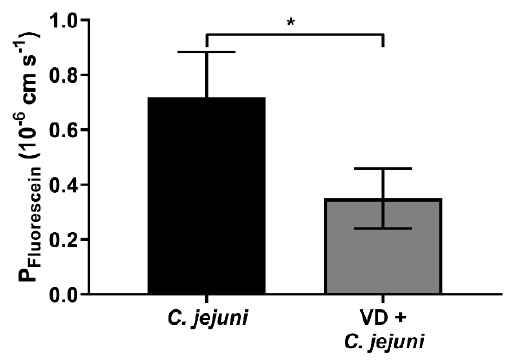
Figure 3. Vitamin D treatment prevents C. jejuni -induced barrier dysfunction in vivo. Secondary abiotic IL-10 − / − mice were orally infected with 10 8 colony forming units (CFU) C. jejuni. Cholecalciferol was administered via the drinking water ad libitum four days prior the infection with C. jejuni . Six days after infection with C. jejuni , mice were scarified, colonic biopsies were mounted immediately in miniaturized Ussing chambers, and fluorescein (332 Da) permeability was measured from the apical to basolateral compartment (* p < 0.05, Mann–Whitney U-test, n = 7–14). Intestinal epithelial barrier dysfunction correlates with changes in the expression or subcellular distribution of tight junction (TJ) proteins. Protein expression of different barrier-relevant TJ proteins in epithelial monolayers was quantified by densitometric analysis of Western blots, and revealed that C. jejuni infection caused no decreases in the expression of the sealing TJ proteins claudin-4, -5, -8, and the TJ proteins claudin-7, or occludin (Table Table 1. Tight junction (TJ) protein expression change from control level (100%) in HT-29/B6- GR/MR cells after C. jejuni infection with or without addition of 200 nM vitamin D. TJ Protein Vitamin D